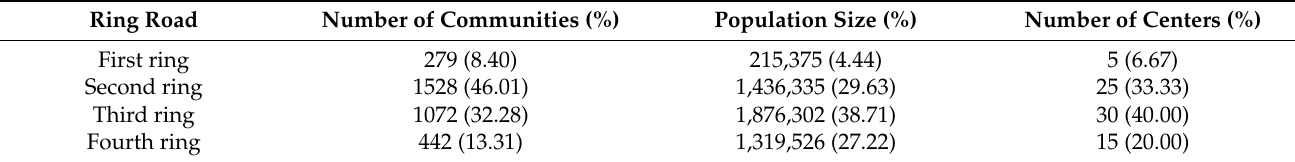
Table 1. Statistics of the healthcare services centers and communities within each ring road. Ring Road Number of Communities (%) Population Size (%) Number of Centers (%) First